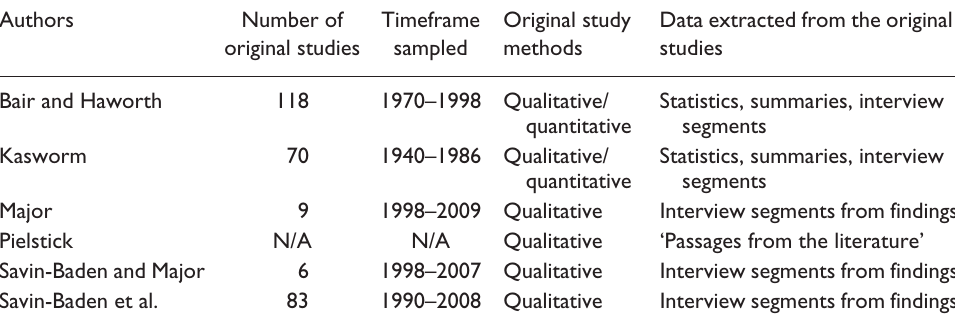
Table 1. Comparison of the original articles used as